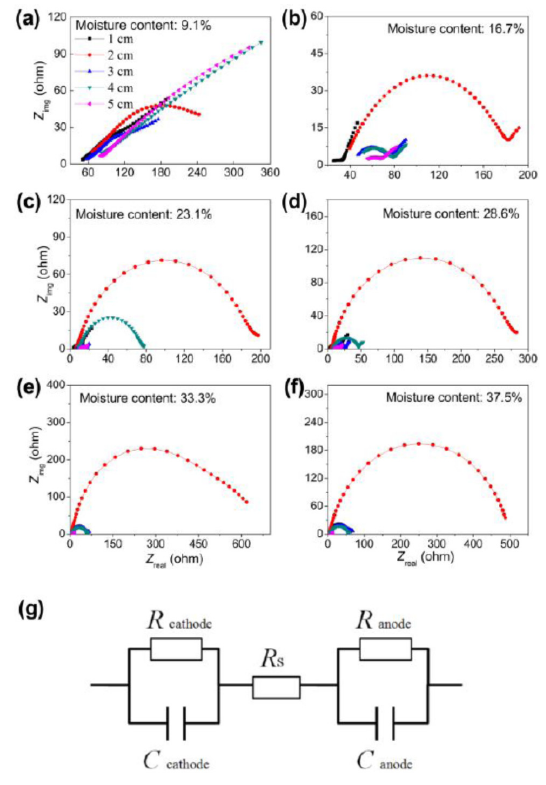
Figure 2. Nyquist plots ( a – f ) of soils of different moisture contents at open circuit potential and the equivalent circuit ( g ) for simulating electrochemical impedance spectroscopy. Table 2. R s , R ct and capacitance at different moisture contents of soil samples. R ct is the sum of R cathode and R anode. C is the sum of C cathode and C anode .